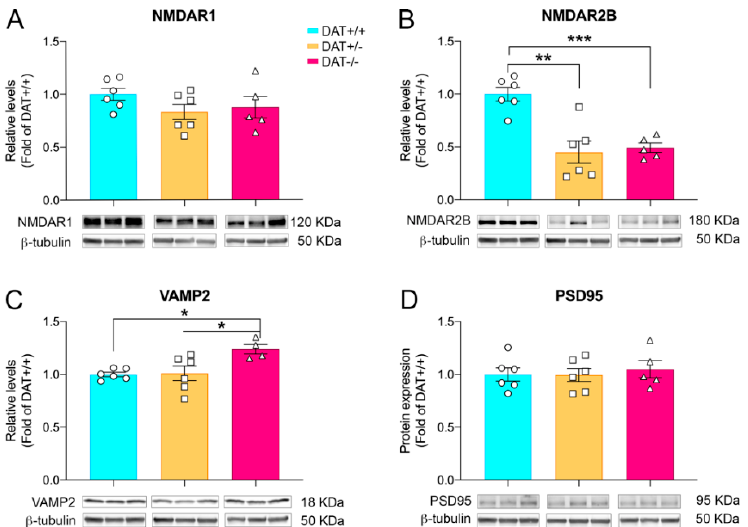
Figure 2. Glutamatergic alterations in female adolescent DAT+/ − and DAT − / − rats. ( A ) Ablation of DAT does not affect NMDAR1 levels. ( B ) Reduction of NMDAR2B levels were found in DAT+/ − and DAT − / − adolescent female rats. ( C ) Significantly increased levels of pre-synaptic VAMP2 protein were observed in DAT − / − rats. ( D ) No changes were observed for post-synaptic PSD95 protein levels. Quantification and representative bands are presented. Individual data points are shown for each group. Data are presented as mean ± SEM; * p < 0.05, ** p < 0.01, *** p < 0.001.